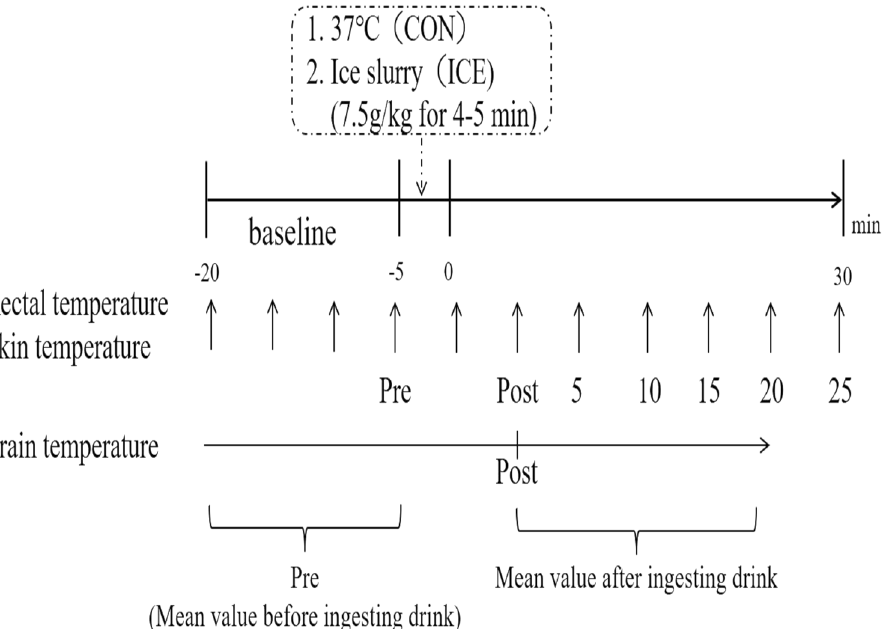
Figure 2. Experimental protocol. A recorded value before beverage ingestion was defined as Pre, and the value at the end of beverage ingestion was defined as Post. For brain temperature, the mean temperature of the 15-min baseline period before beverage ingestion was defined as Pre. All physiological measurements are presented in 5-min increments from Post to 30 min ( +